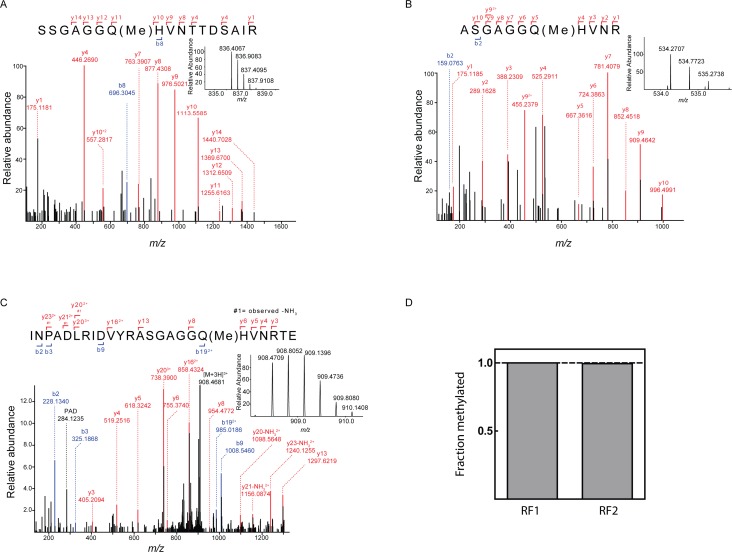
Quantification of release factor methylation by mass spectrometry.(A) MS/MS spectrum of methylated peptide derived from RF1-Cy5 by proteolysis with trypsine. Inset: MS spectrum (m/z = 836.4059) of the intact methylated peptide (z = 2). (B) MS/MS spectrum of the methylated peptide derived from RF2-Cy5 by proteolysis with trypsine. Inset: MS spectrum (m/z = 534.2707) of the intact methylated peptide (z = 2). The exceptional hydrophilicity of the peptide hampered a reliable relative quantification. (C) MS/MS spectrum of methylated peptide derived from RF2-Cy5 by proteolysis with GluC. Inset: MS spectrum (m/z = 908.4706) of the intact methylated peptide (z = 3). (D) Relative quantification of the methylation efficiency. Methylated and unmethylated peptide was quantified by MS1 full scan filtering and the fraction of methylated peptide was quantified assuming similar ionization properties of both peptides. Mean values were calculated from three technical replicates with error bars (±0.001) representing standard deviation (too small to be seen).